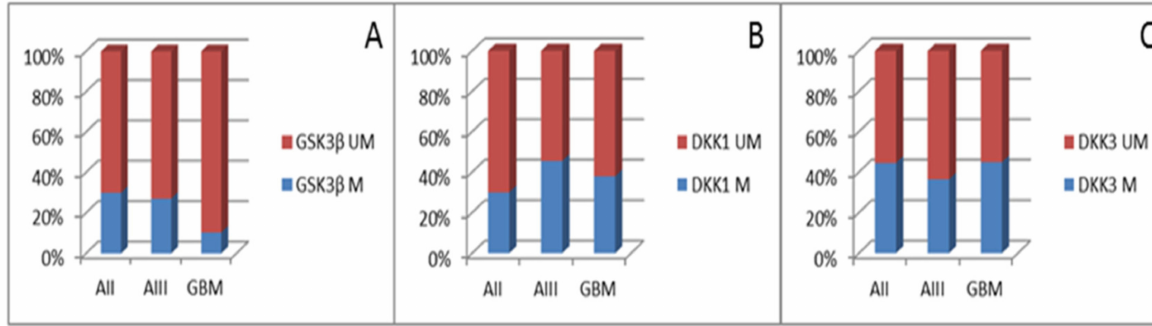
Figure 3. Graph showing the percentage of samples with methylated (M) and unmethylated (UM) promoter of ( A ) GSK3 β , ( B ) DKK1 , and ( C ) DKK3 in astrocytic brain tumors grade II–IV.